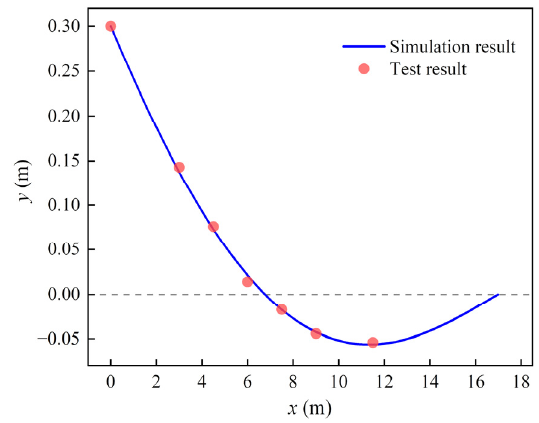
Figure 23. Static configuration of the model SCR.